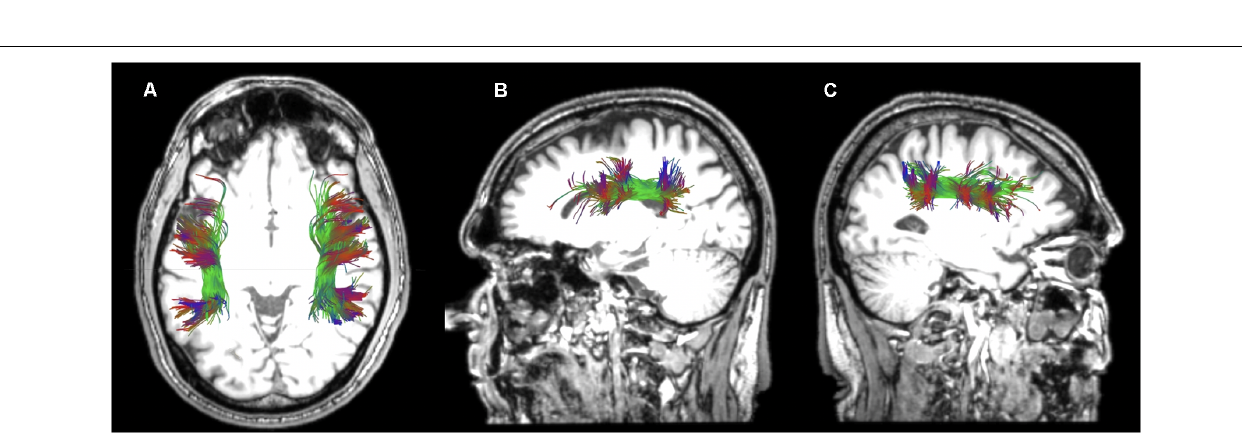
FIGURE 5 | Horizontal (A) and sagittal views of the reconstructed left (B) and right (C) superior longitudinal fasciculus II of a healthy participant in native space.